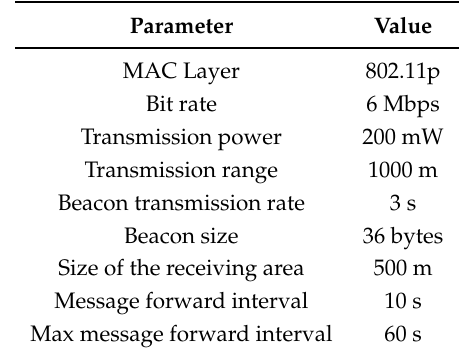
Table 4. Network parameters.